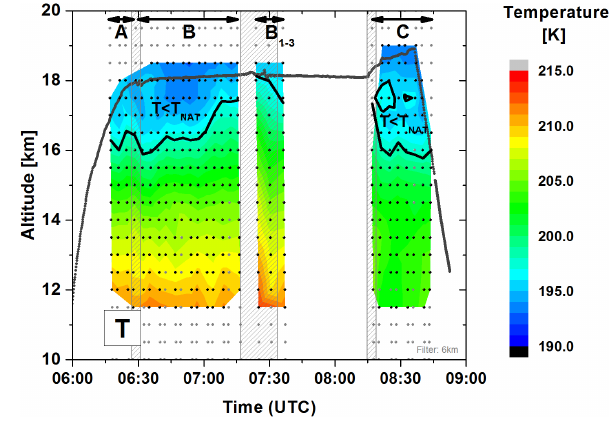
Figure 4. Vertical cross section of temperature retrieved from the MIPAS-STR observations associated with the flight on 25 January 2010. The solid black lines indicate levels where temperatures re- trieved from MIPAS-STR are equal to calculated T NAT (see text). The flight altitude of the Geophysica is indicated by a solid grey line. The retrieval grid is indicated by black dots. Grey dots were excluded from interpolation due to low vertical resolution. Grey hatched areas indicate turns performed by the Geophysica , where the retrieval results are characterised by increased uncertainties (from Woiwode PhD thesis, 2013, with